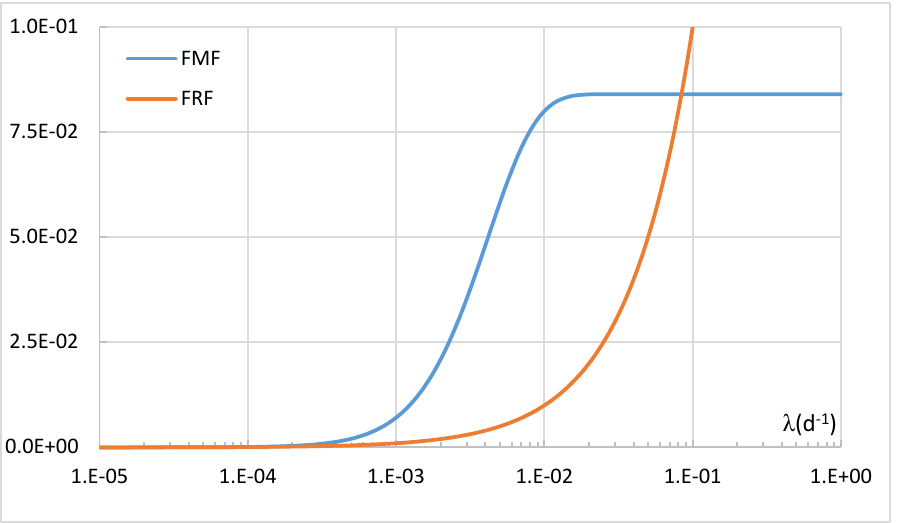
λ = 8.40 × 10 − 2 d − 1 ). ). Figure 10. The third interval of 16 months ( −2 −1 𝜆𝜆 = 8.40 × 10 𝑑𝑑 Global